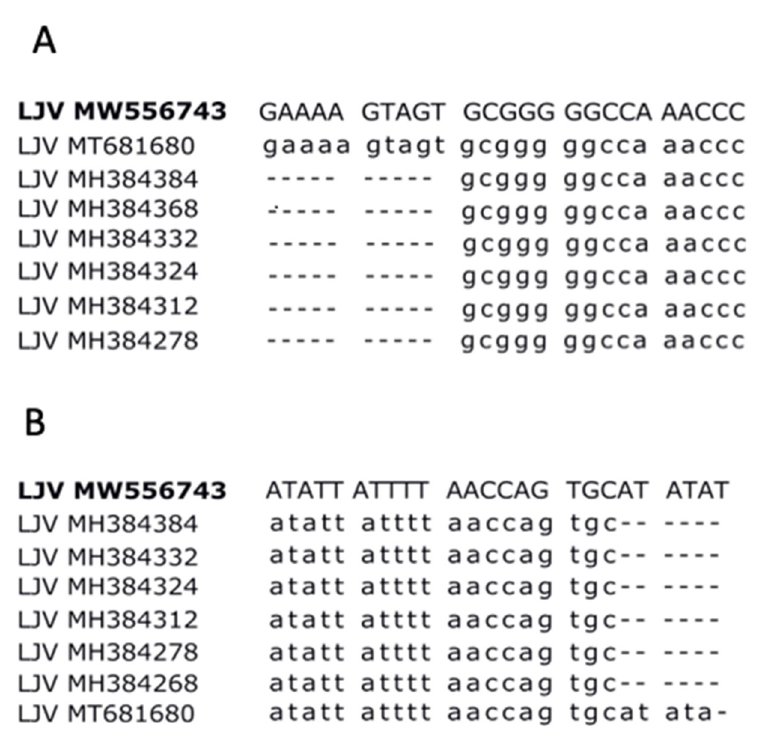
Figure 3. Comparison of the 5 ′ -UTR and 3 ′ -UTR sequences of known La Jolla virus (LJV) strains. ( A ) The 5 ′ -UTR of LJV-Ds-OS20 (LJV MW556743) compared to seven other LJV strains. ( B ) The 3 ′ -UTR of LJV-Ds-OS20 (LJV MW556743) compared to seven other LJV strains.